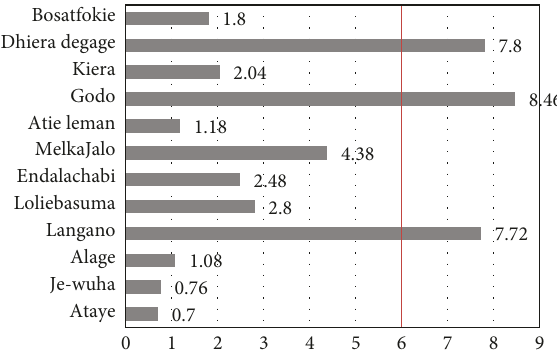
Figure 3: Silt content (source: laboratory study).